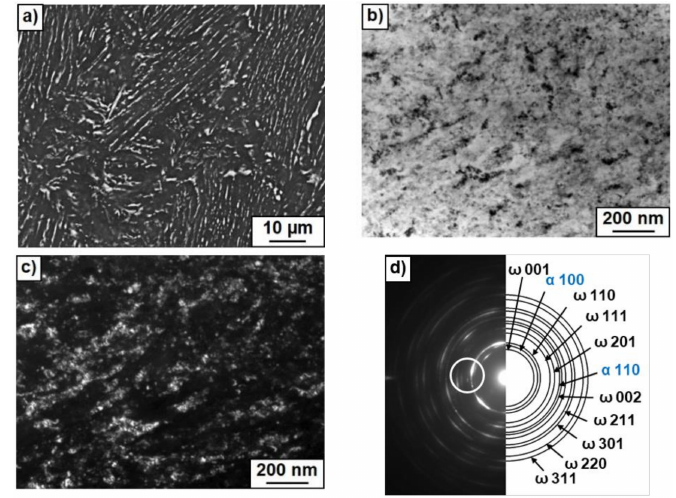
Figure 4. Microstructure of Ti–4 wt.% Co alloy after annealing at 500 ◦ C and high pressure torsion (HPT). ( a ) Scanning electron microscopy (SEM) micrograph. ( b ) Bright field and ( c ) dark field transmission electron microscopy (TEM) micrographs after annealing at 400 ◦ C and following HPT. ( d ) Selected area electron diffraction